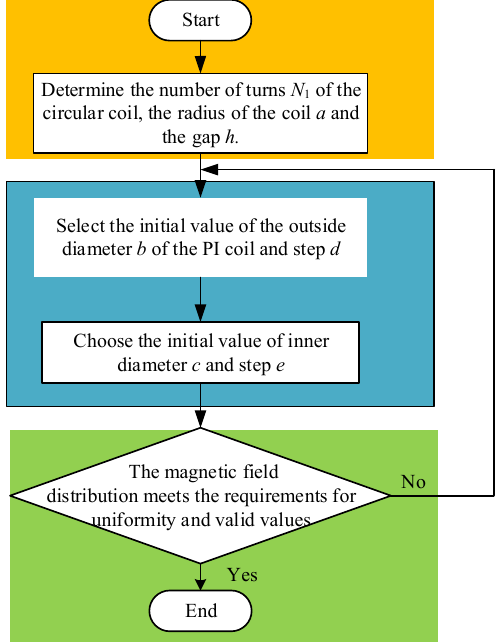
Figure 8. Design flowchart of parameters b and c .